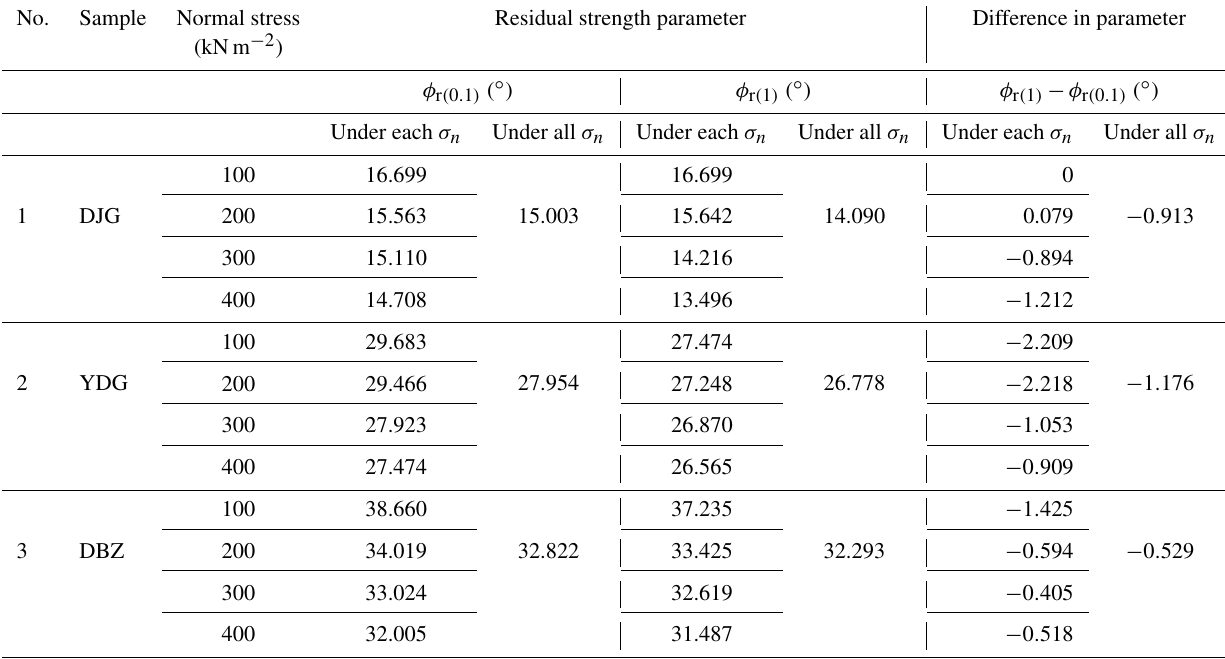
Table 2. Residual shear strength parameter of landslide soils.